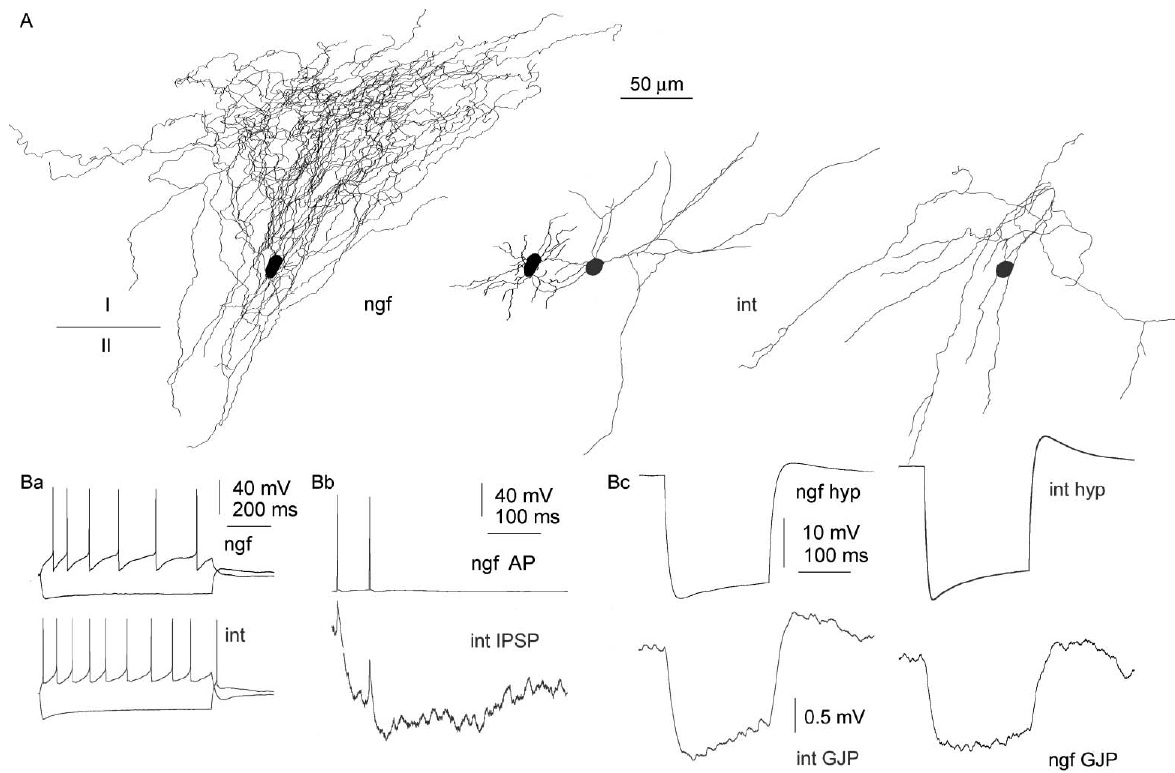
Figure 2. Human neurogliaform cells are involved in electrical coupling . ( A ) Three-dimensional light microscopic reconstructions of an electrically coupled neurogliaform cell (ngf, black) and a different type of interneuron (int, gray) in layer I of the human cerebral cortex. Axonal (left and right) and dendritic (middle) reconstructions are separated for clarity, the dendritic arborizations show the original position of the interneurons. ( Ba ) Firing patterns of the neurogliaform cell and the interneuron. ( Bb ) Action potentials in the neurogliaform cell triggered postsynaptic spikelets in the interneuron followed by long-lasting IPSPs. ( Bc ) Reciprocal transmission of hyperpolarizing current pulses injected into the neurogliaform cell (left) or the interneuron (right) confirmed electrical coupling between the two cells.